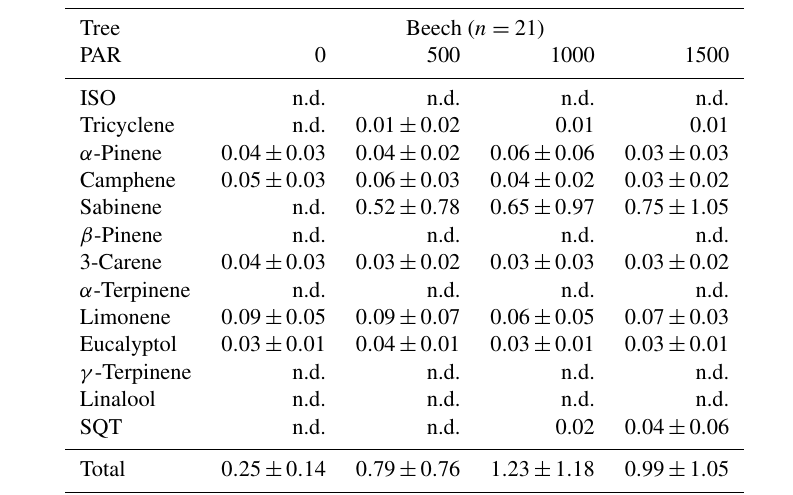
Table A2. The mean average actual emission ( ± SD) of detected compounds at light levels (PAR) 0, 500, 1000 and 1500µmolm − 2 s − 1 and the number of samples taken from European beech ( Fagus sylvatica ) in µggdw 1 h − 1 . No data (n.d.) indicates that the compound was not detected in any sample for the measured light level on that particular tree.